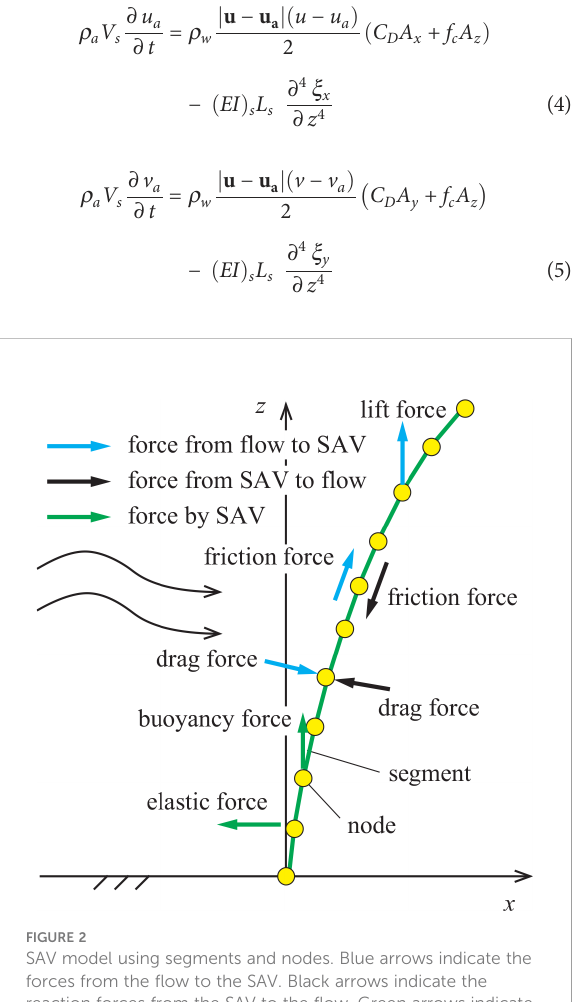
FIGURE 2 SAV model using segments and nodes. Blue arrows indicate the forces from the fl ow to the SAV. Black arrows indicate the reaction forces from the SAV to the fl ow. Green arrows indicate the forces due to buoyancy and